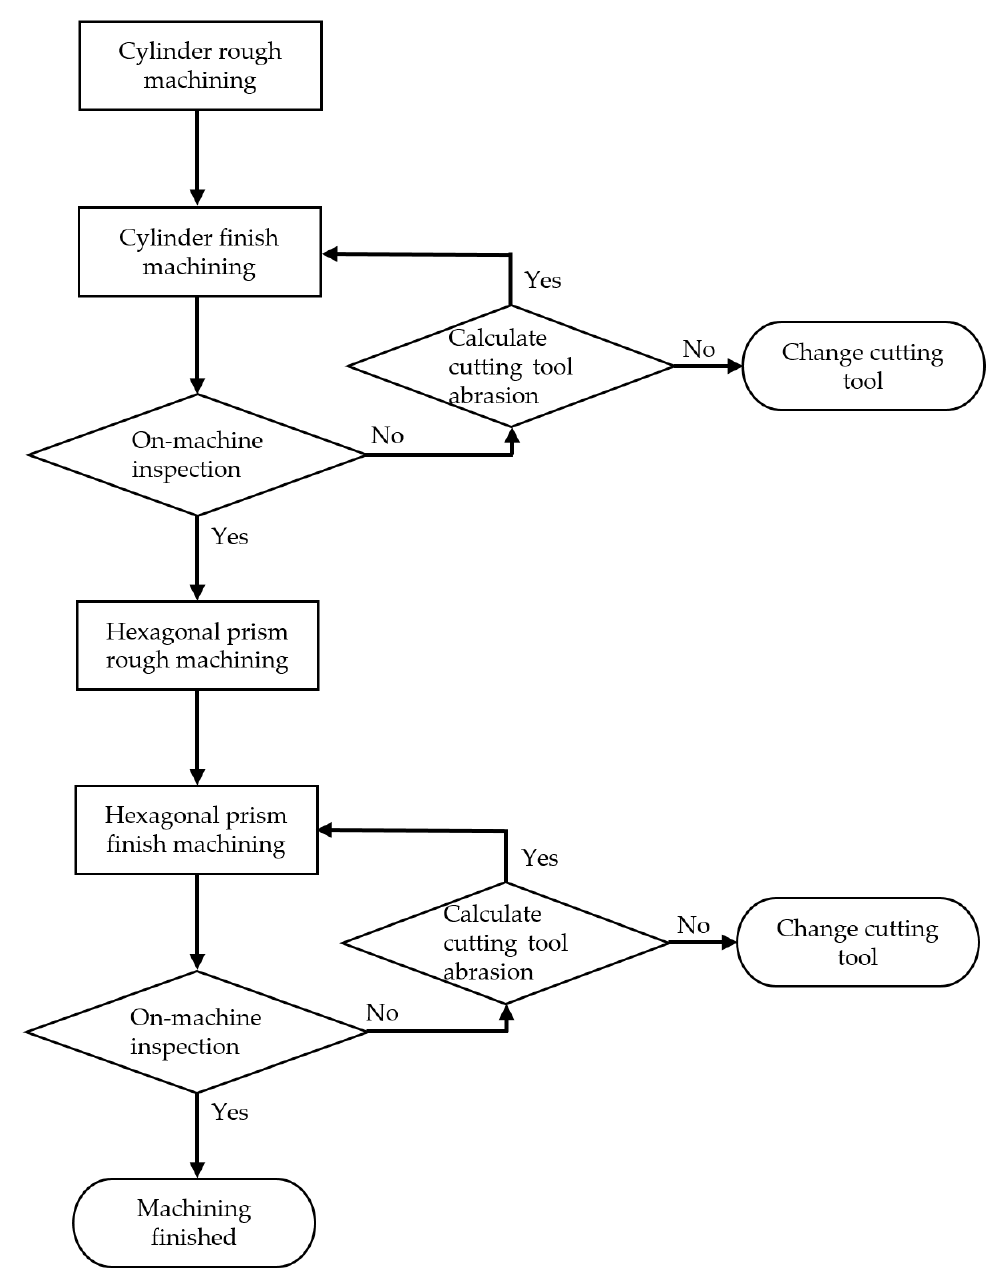
Figure 5. Flow chart of the procedure of inspection on the hexagonal punching machine.